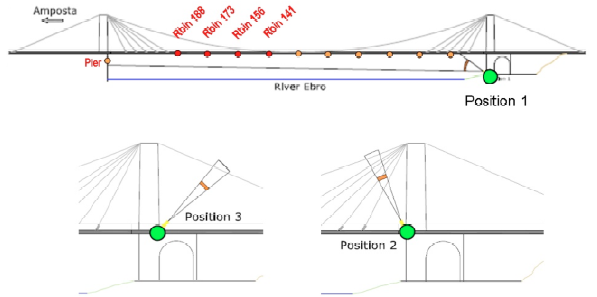
Figure 5. Geometrical configurations used during the experimental campaign